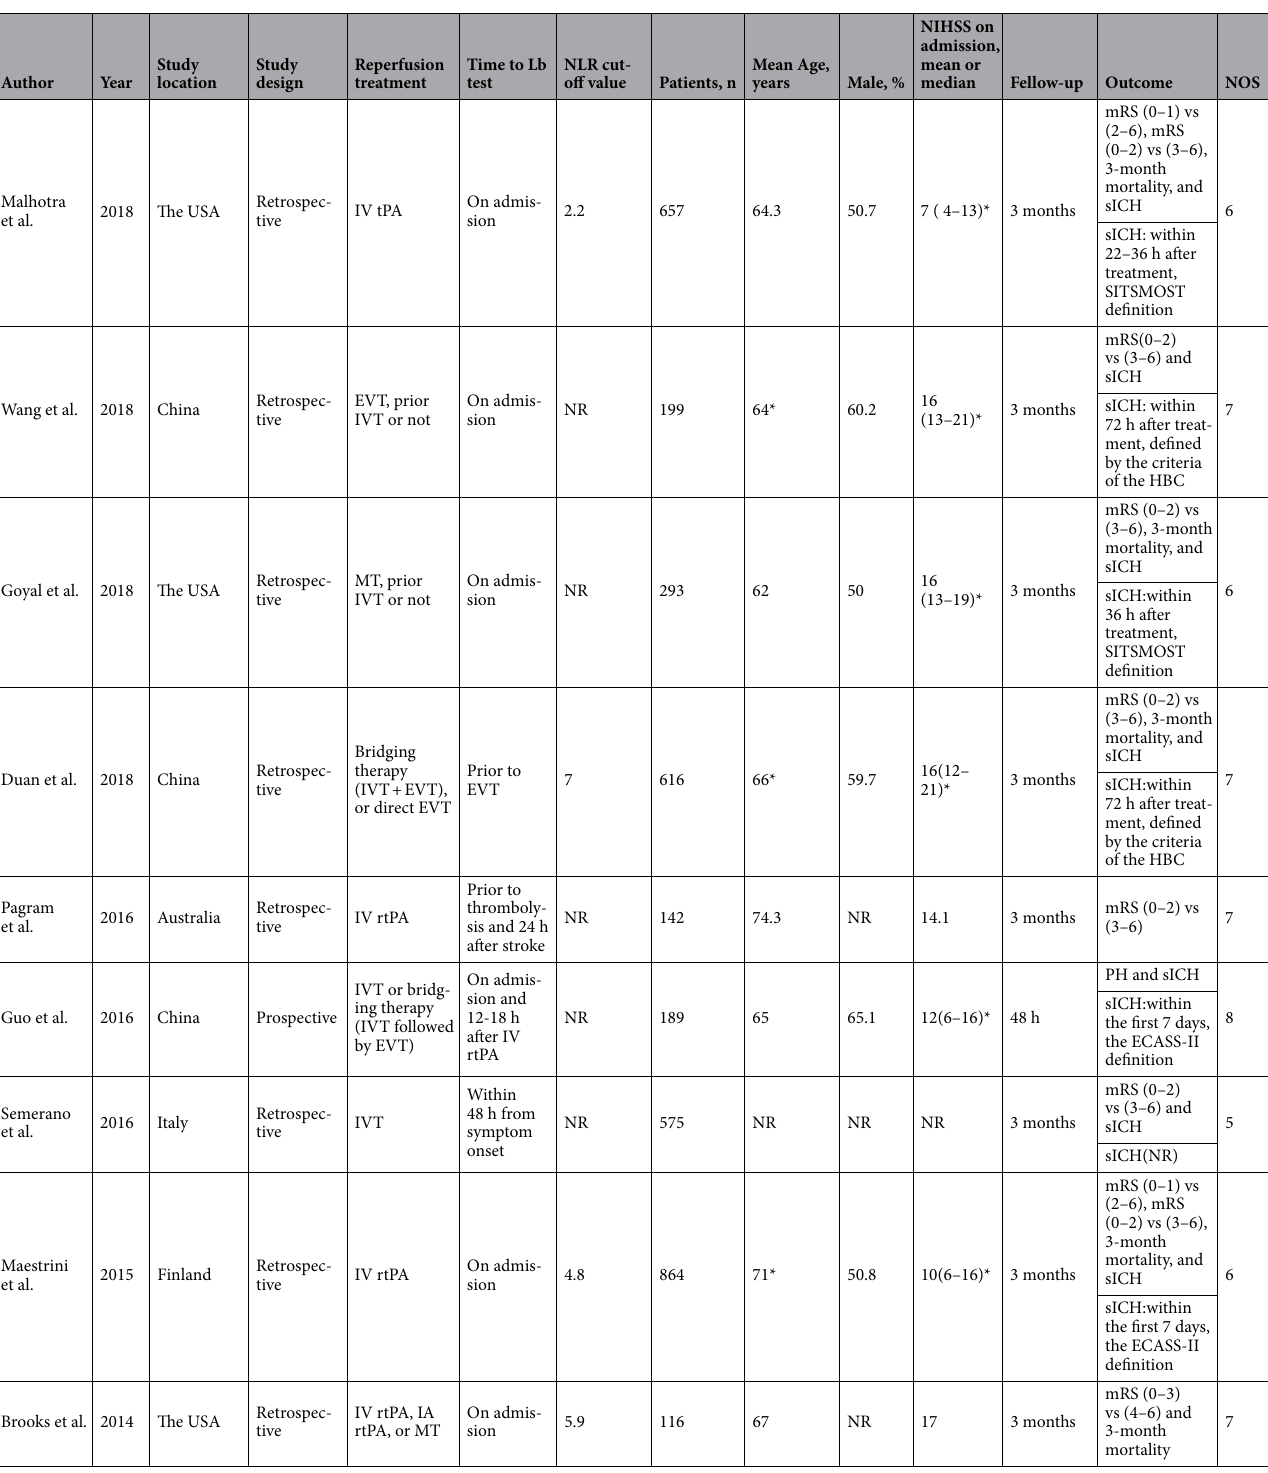
Table 2. Main characteristics of studies included in the meta-analysis. Lb laboratory, IV intravenous, IVT intravenous thrombolysis, EVT endovascular treatment, MT mechanical thrombectomy, IA Intra-artery, SITSMOST Safe Implementation of Thrombolysis in Stroke-MOnitoring Study, Lumbar Disc Herniation, HBC Heidelberg bleeding classification, the ECASS-II definition the European Cooperative Acute Stroke–II definition, PH parenchymal hematomas, NR not reported. *Median, Confidence